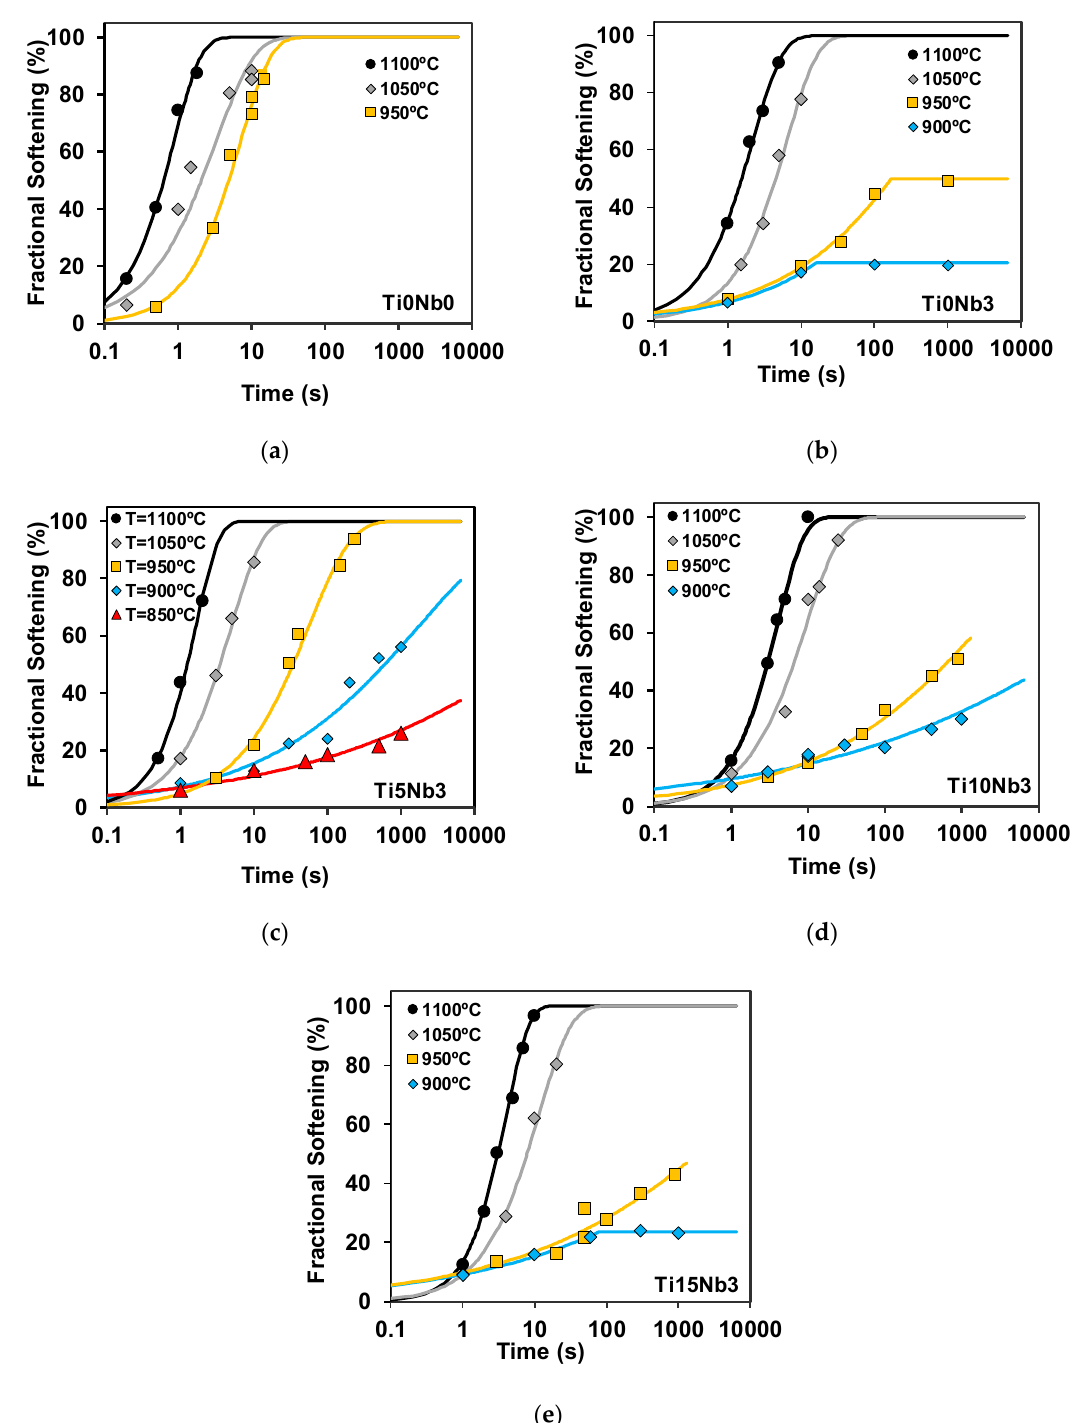
Figure 6. Softening curves obtained for the steels investigated at constant strain and strain-rate conditions ( 𝜀 = 0.35, 𝜀(cid:4662) = 1 s − 1 ) and different temperatures after roughing pass application. ( a ) Ti0Nb0 steel, ( b ) Ti0Nb3 steel, ( c ) Ti5Nb3 steel, ( d ) Ti10Nb3 steel and ( e ) Ti15Nb3 steel.